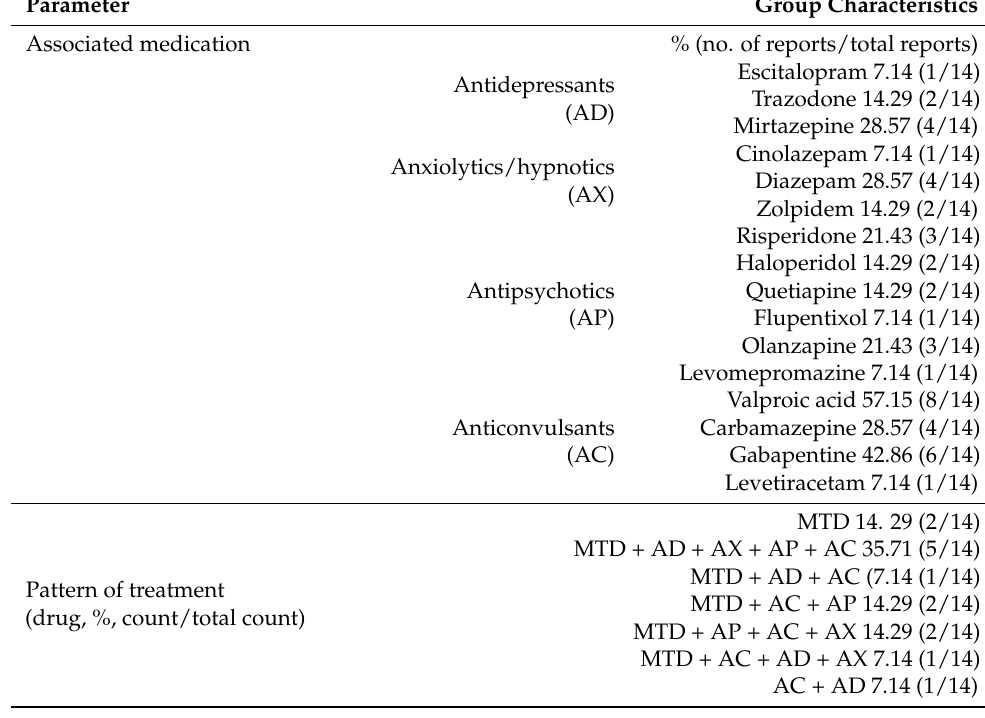
Table 2. Cont. Parameter Group